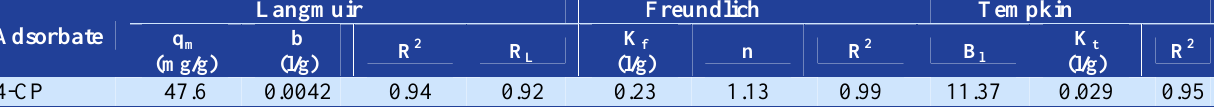
Figure 4. (a) Effect of initial concentration on the adsorption of 4-CP (contact time = 40 minutes, adsorption dosage = 1 g/l, and pH = 2) and (b) Langmuir, (c) Freundlich, and (d) Tempkin isotherms Table 2. Parameters of Langmuir, Freundlich, and Tempkin isotherms